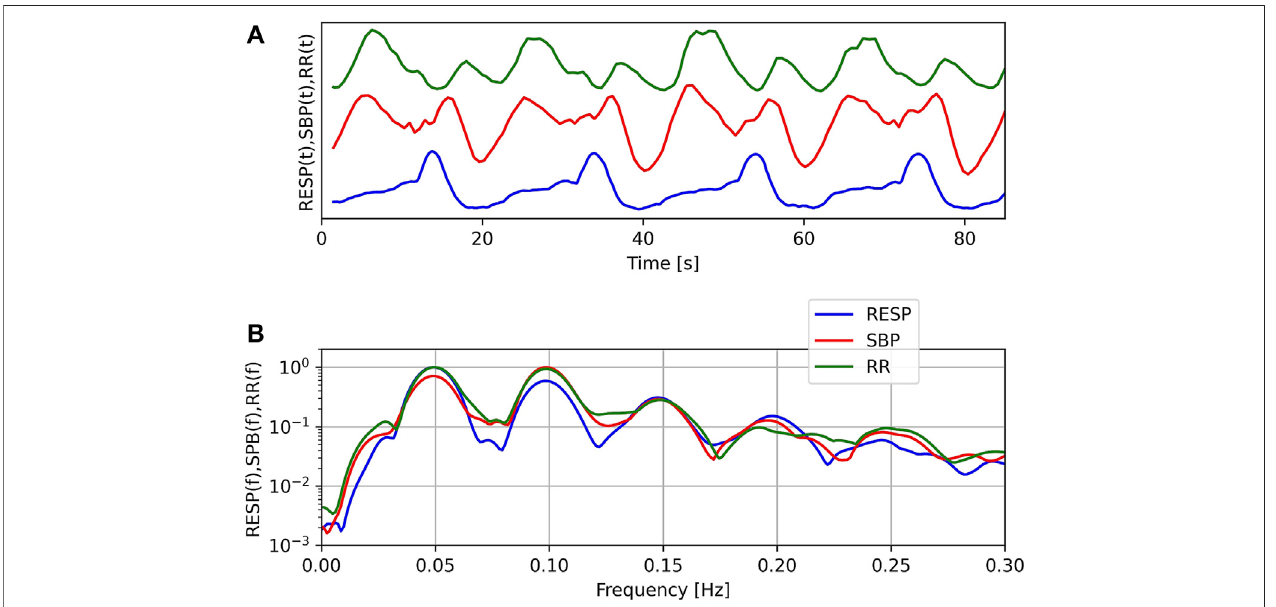
FIGURE 2 | Example of respiration (RESP), systolic blood pressure (SBP) and RR-tachogram (RR) of one subject during OM chanting (A) and corresponding normalised spectra (B) . Note: In the top fi gure, no units are given, since we compare the temporal structure of the signals in time and the offset of SBP is unknown.